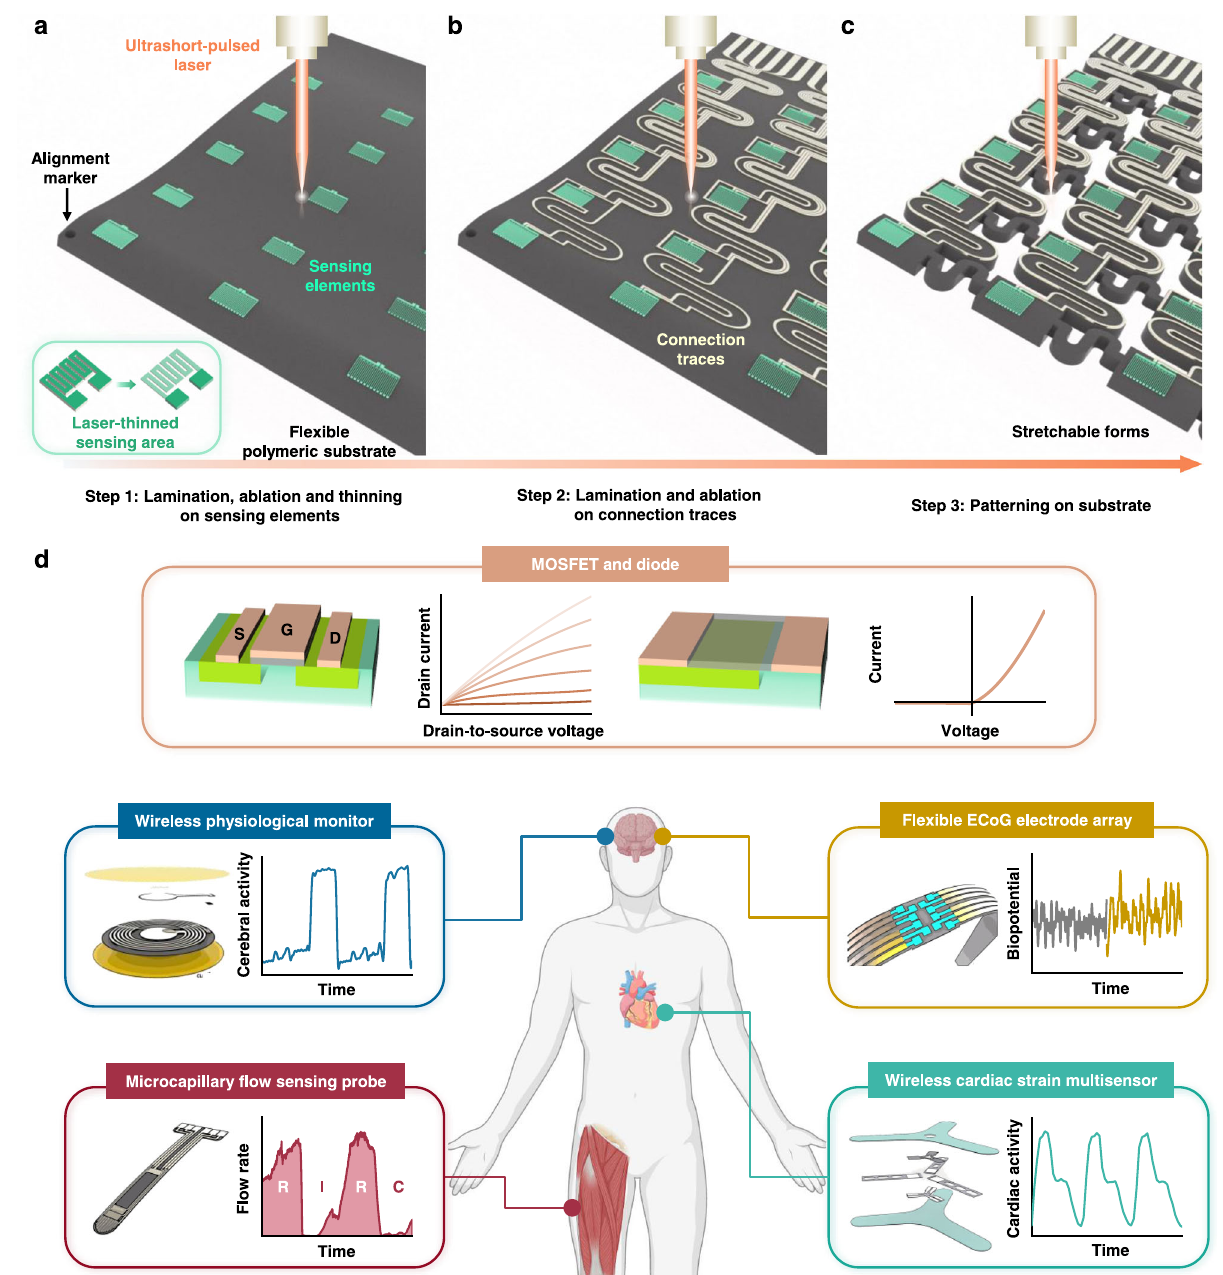
Fig. 1 | Laser ablation processes for fabricating advanced multi-layered bior- esorbable electronics. Laser ablation fabrication procedures for bioresorbable electronics, including patterning of sensing elementsand structuringofalignment markers ( a ), patterning of connection traces ( b ), and structuring substrates into stretchable forms ( c ). Inset: laser thinning process on the sensing elements in a . d Illustrations of a representative collection of bioresorbable electronic systems fabricated using these procedures, such as Si-based semiconductor devices and